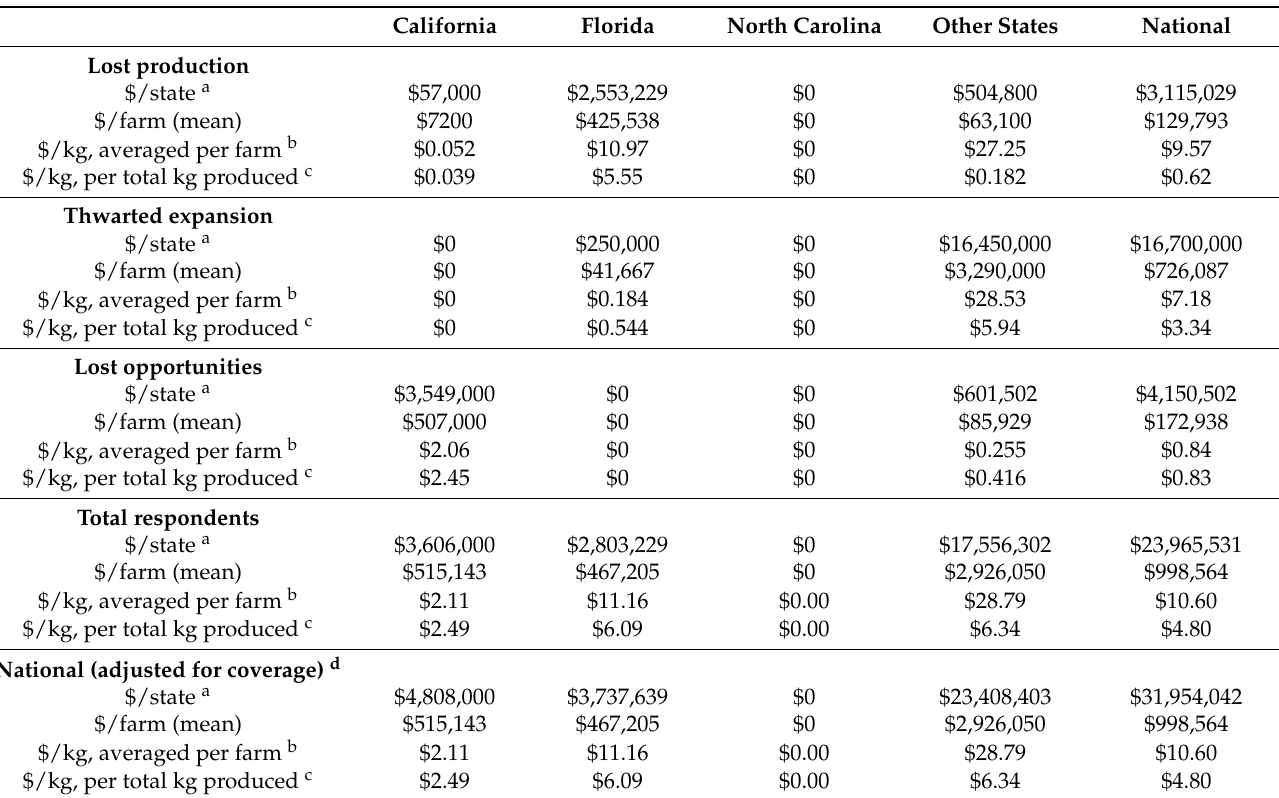
Table 12. Lost revenue from lost production, thwarted expansion, and lost